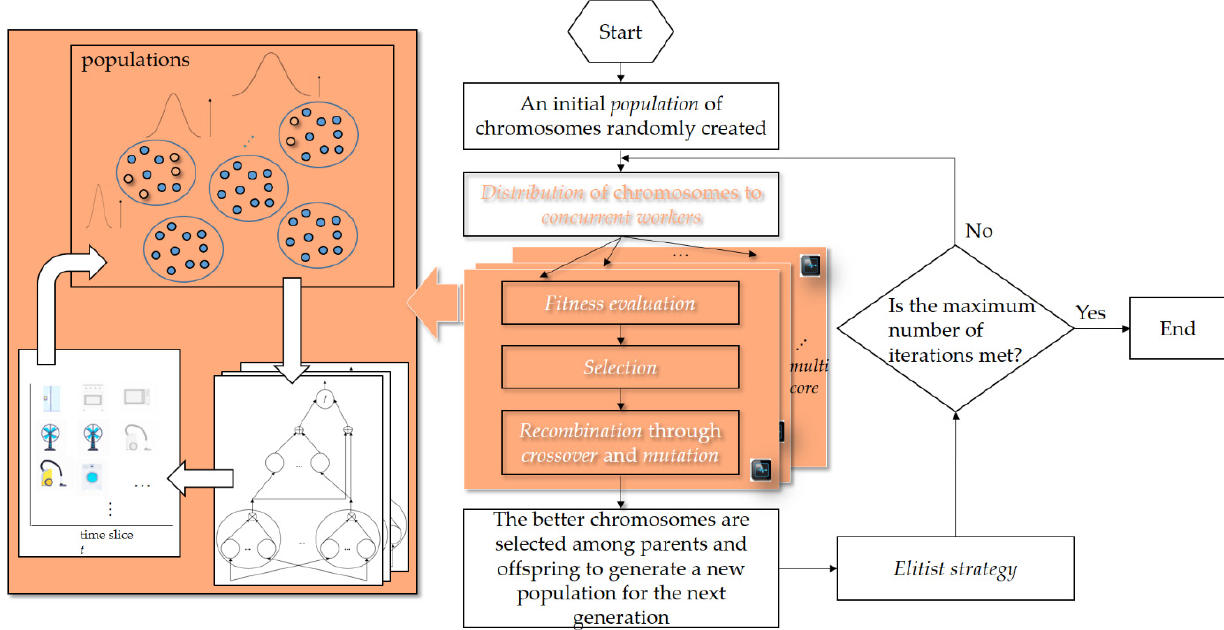
Figure 4. Flowchart of the computational routines involved for fitness evaluation of the parallel GA used to evolve the k-Means-clustering-hybridized neuro-fuzzy classifier for energy decomposition in this research.